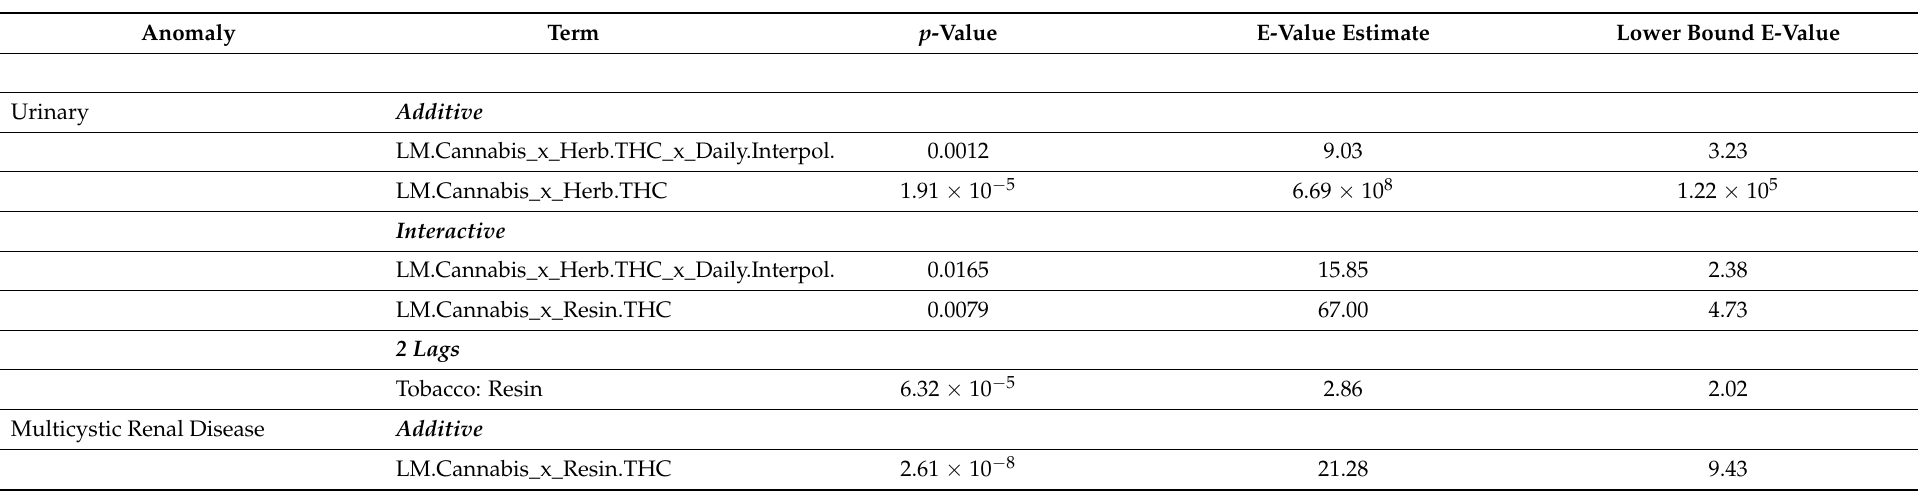
Table 7. E-Values from Multivariable Panel Regression